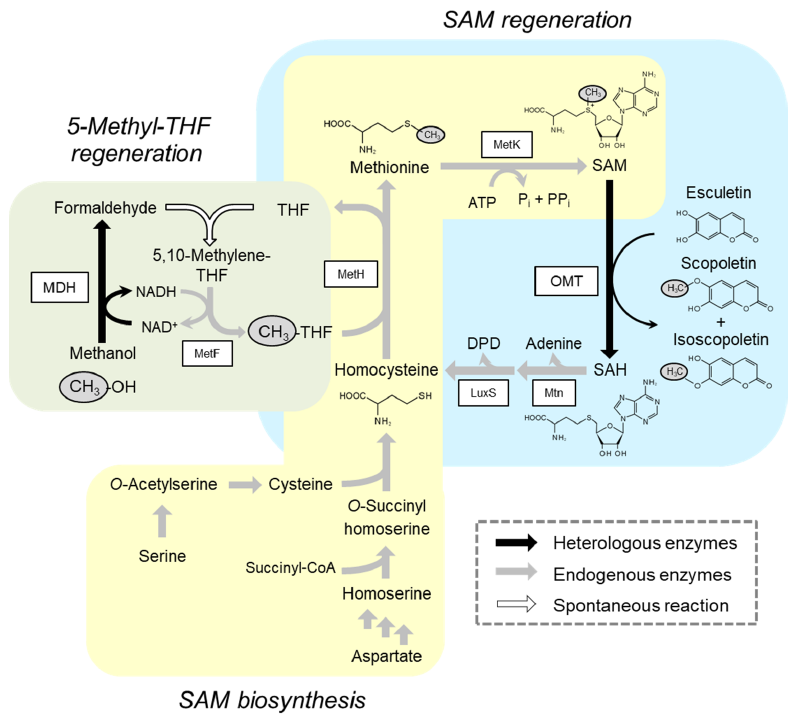
Figure 1. Schematic illustration of the SAM biosynthetic / regeneration and the MDH-driven 5-methyl-THF regeneration pathways with esculetin methylation. Methyl groups originating from methanol can be transferred to SAM via 5-methyl-THF and methionine. SAM is then utilized for esculetin methylation to scopoletin and isoscopoletin. Abbreviations used: SAM, S -adenosylmethionine; SAH, S -adenosylhomocysteine; THF, tetrahydrofolate; DPD, 4,5-dihydroxypentane-2,3-dione; ATP, adenosine triphosphate; NAD + / NADH, nicotinamide adenine dinucleotide; P i , phosphate; PP i , pyrophosphate; MDH,methanoldehydrogenase;OMT, O -methyltransferase; MetF,5,10-methylene-THF reductase; MetH, methionine synthase; MetK, SAM synthase; Mtn, SAH nucleosidase; LuxS, S -ribosylhomocysteine